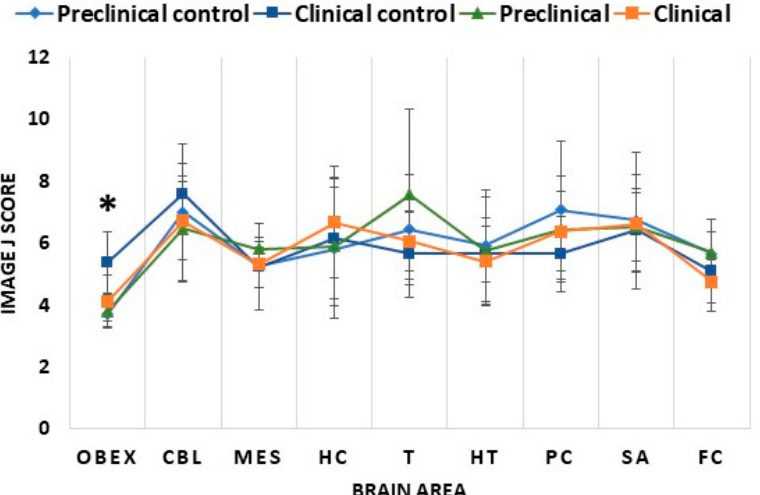
Figure 4. Comparison of 5mC Image J scores of the studied brain areas in the different mice groups: preclinical control, clinical control, preclinical, and clinical mice. The nine studied areas were the obex, cerebellum (CBL), mesencephalon (MES), hippocampus (HC), thalamus (T), hypothalamus (HT), parietal cortex (PC), septal area/striatum (SA), and frontal cortex (FC). The data are presented as mean values ± SEM. * Significant difference between clinical control and clinical mice ( p < 0.05).